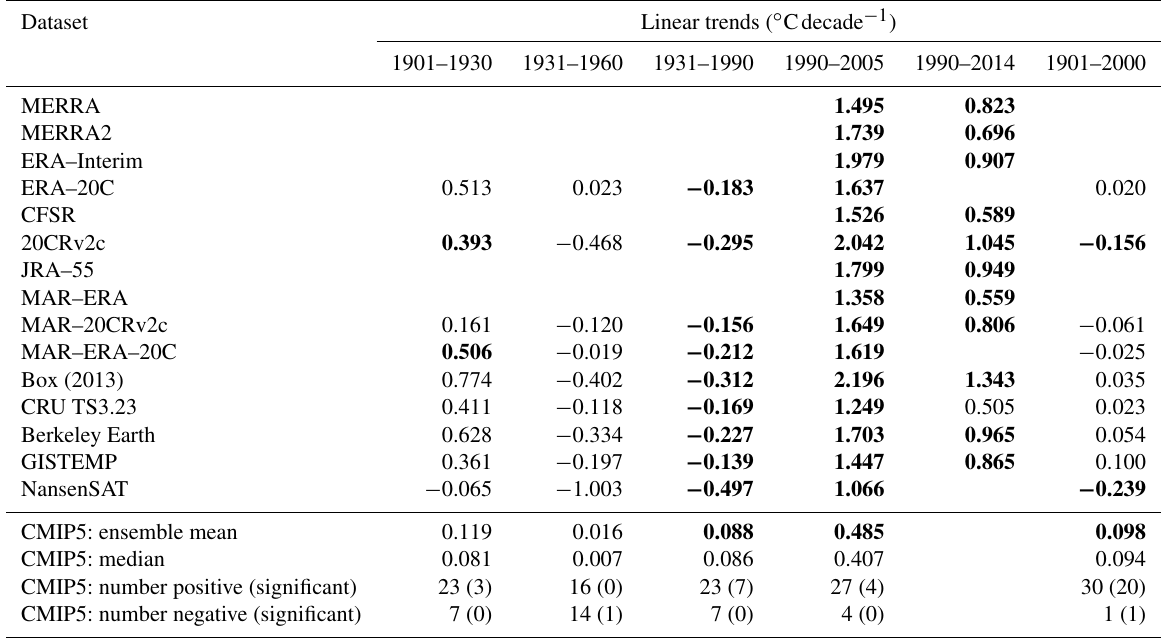
Table 4. Trends ( ◦ Cdecade − 1 ) of ice sheet areal average annual mean SAT for given periods. For the CMIP5 ESMs, the trend of the ensemble mean and the median of the individual trends are shown, along with the number of positive, negative and significant trends. Bold type indicates significance at the 0.05